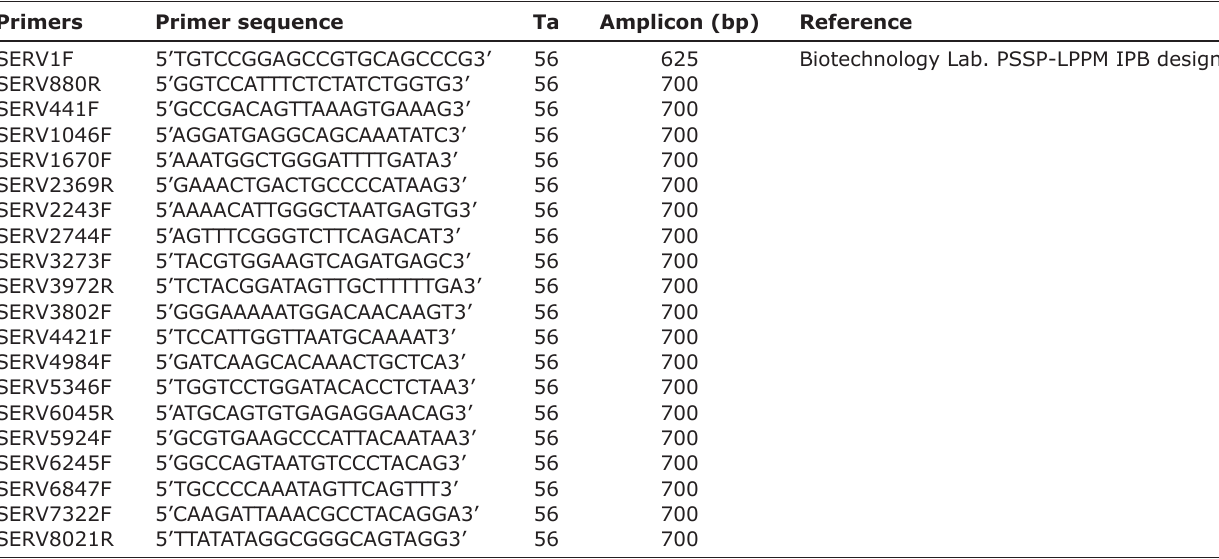
Table-1: List of primers used for whole-genome sequencing in this study. Primers